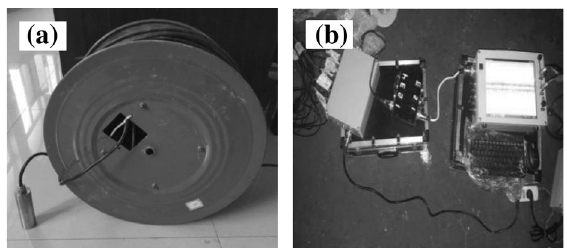
Figure 3. Data acquisition system: ( a ) Sensors and cables. ( b ) Data hubs, converters, and signal collectors.